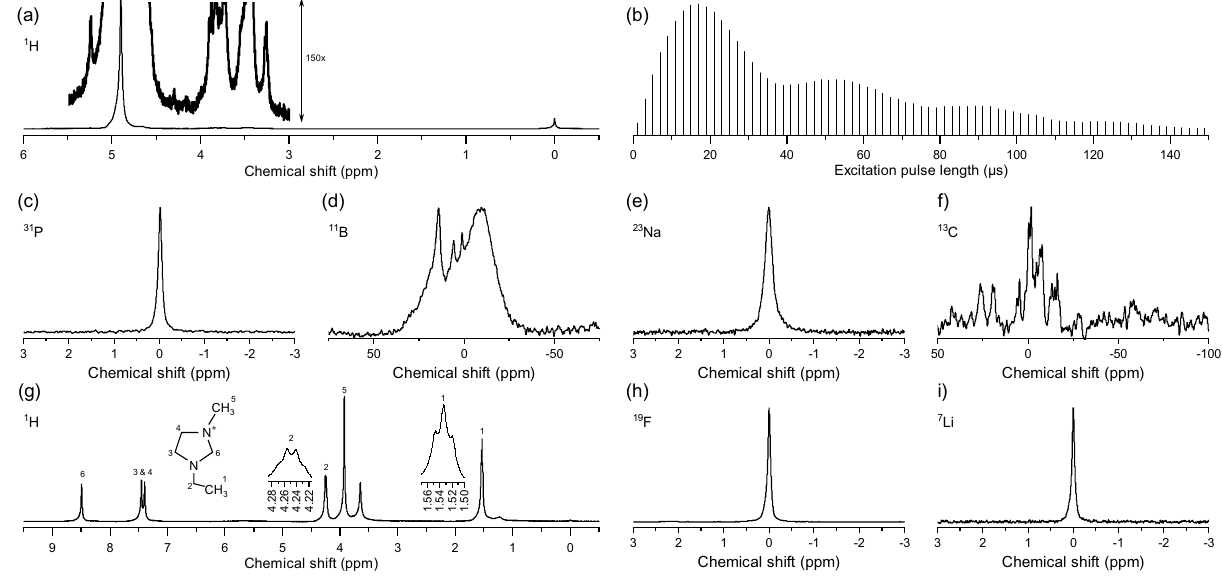
Figure 3. NMR experiment using the optimised NMR detector to observe different nuclei: ( a ) 1 H NMR spectrum (at 500 MHz) of the aqueous sample. The inset shows the same spectrum with enlarged amplitude. ( b ) 1 H nutation signal. ( c ) 31 P NMR spectrum (at 202 MHz) of the aqueous sample. ( d ) 11 B NMR spectrum (at 160 MHz) of the aqueous sample. ( e ) 23 Na NMR spectrum (at 132 MHz) of the aqueous sample. ( f ) 13 C NMR spectrum (at 126 MHz) of the aqueous sample. ( g ) 1 H NMR spectrum (at 500 MHz) of the electrolyte sample. ( h ) 19 F NMR spectrum (at 471 MHz) of the electrolyte sample. ( i ) 7 Li NMR spectrum (at 194 MHz) of the electrolyte